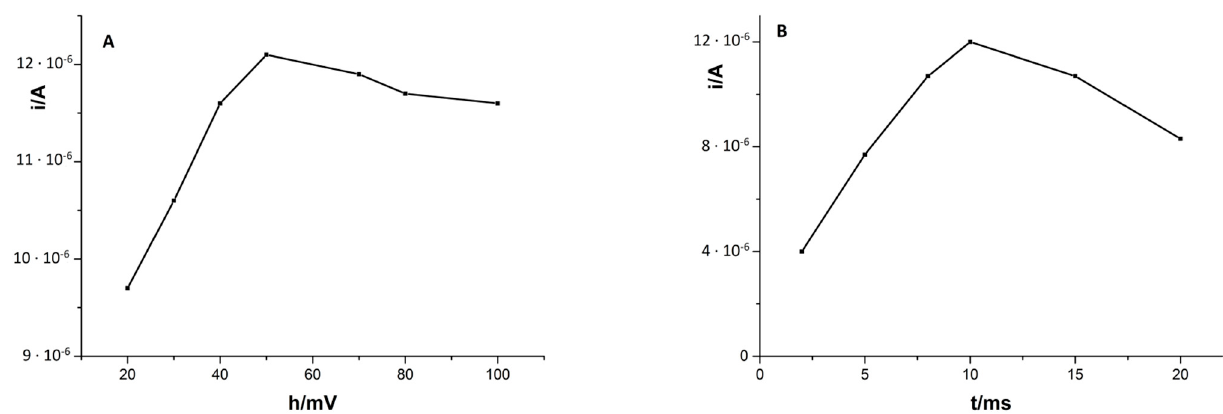
8 of 20 Figure 2. Influence of accumulation time on the Cd(II) signal. Composition of solution 5 × 10 − 8 M Cd(II), 2 × 10 − 4 M Cu(II), and 0.1 M HCl. Accumulation potential − 0.7 V. 3.4. Pulse Time and Pulse Height The pulse time and pulse height also have effects on the cadmium peak intensity, so they were also examined. The pulse time was examined from 2 to 20 ms, and it turned out that, with an increase in pulse time above 10 ms, the signal of Cd(II) decreased, and hence for further tests the value of 10 ms was chosen. The variation of the pulse height between